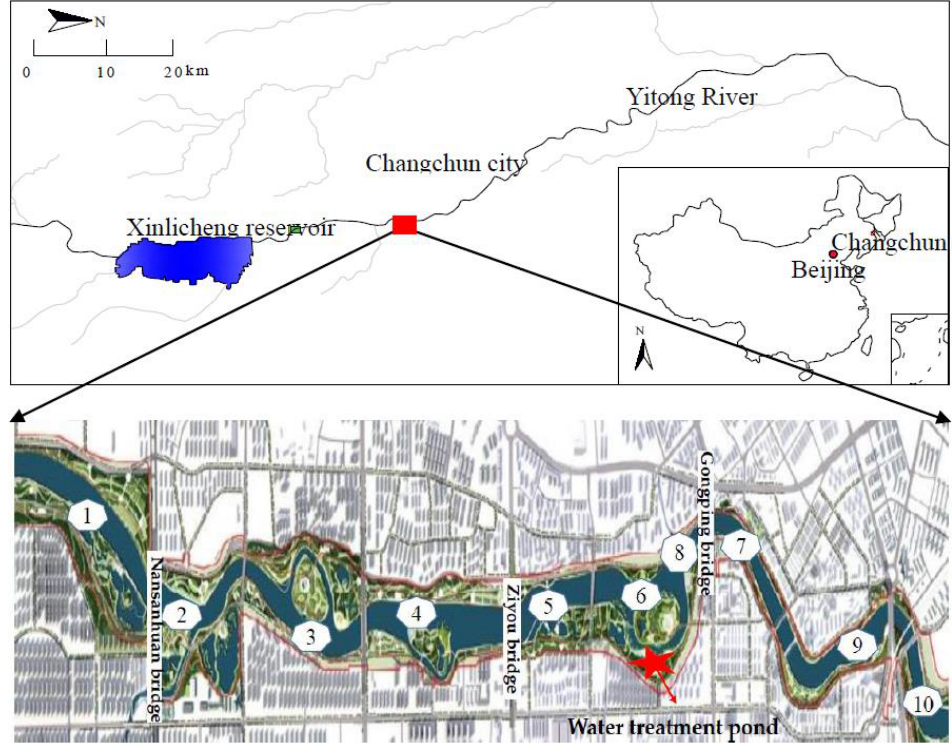
Figure 1. The location of the water treatment pond and the distribution of sampling sections.